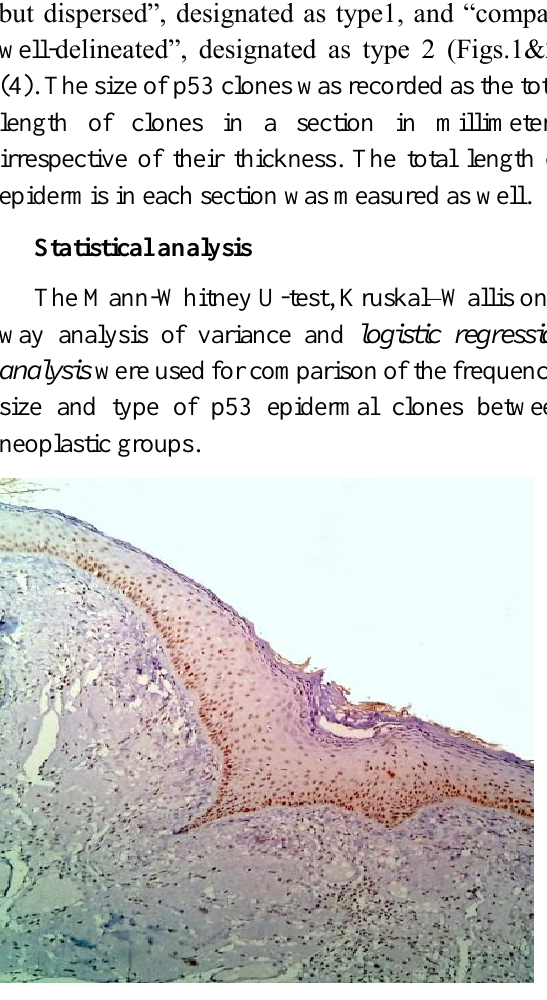
Fig. 1. Weak Epidermal P53 Staining Intensity (×100) Table 1. Frequency of p53 Clones mm -1 of Normal Peri-Lesional Skin of Basal Cell Carcinoma (BCC) and Squamous Cell Carcinoma (SCC) and Melanocytic Nevi